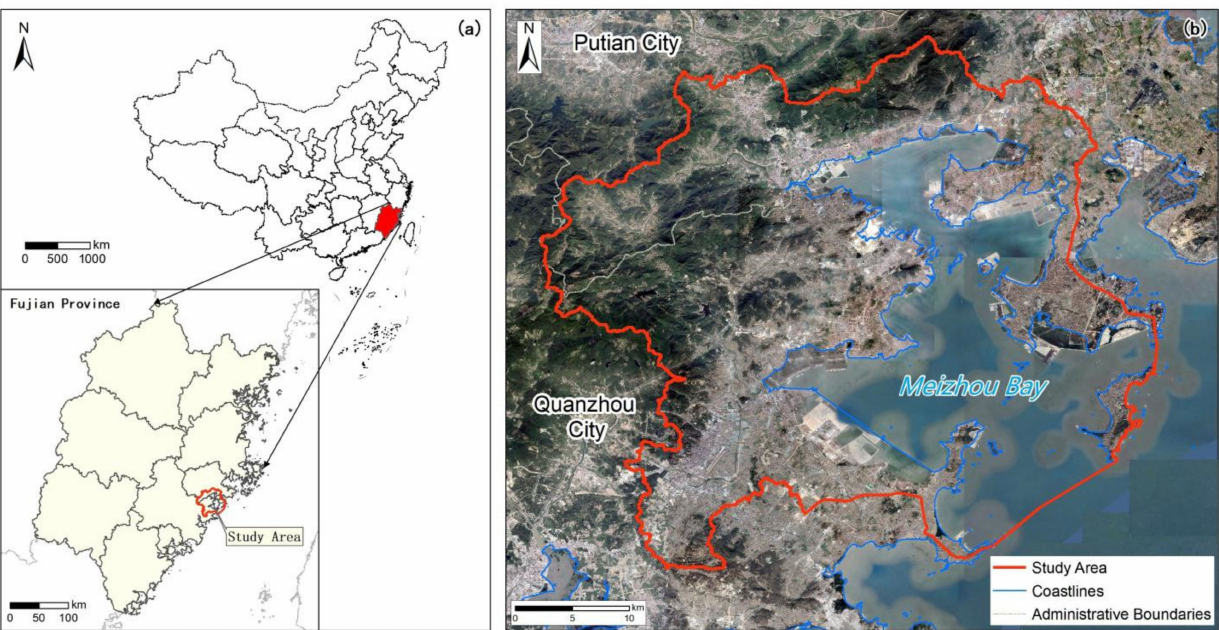
Figure 1. The location of study area: ( a ) the location of Meizhou Bay (located at the junction of Quanzhou City and Putian City in central Fujian), and ( b ) status of Meizhou